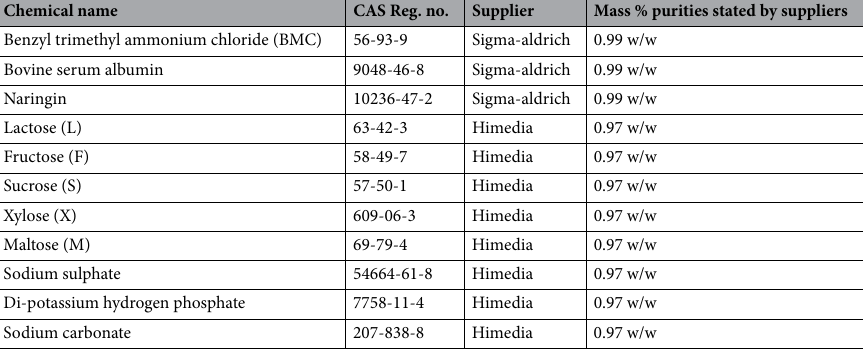
Table 1. Source and purity of chemicals used in the preparation of NADES and extractive